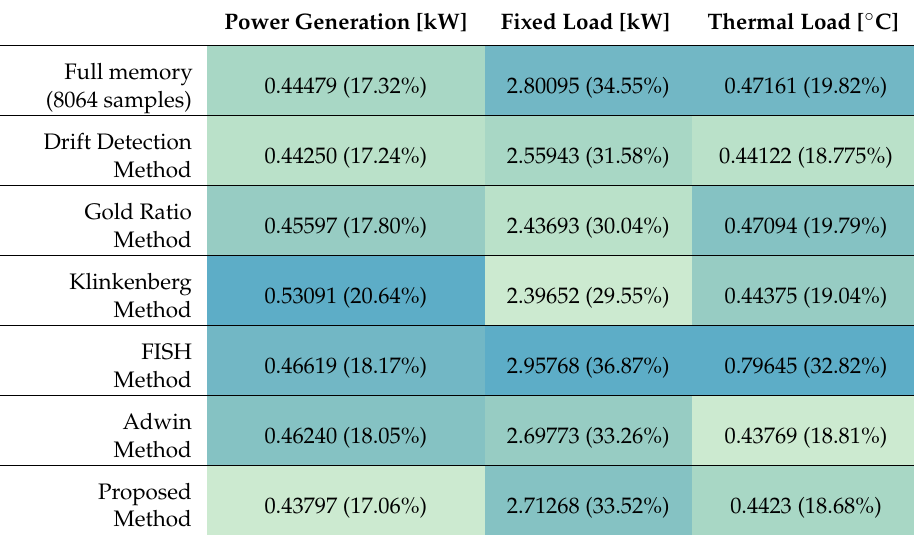
Table 2. Average RMSE and average NRMSE for a summer day.